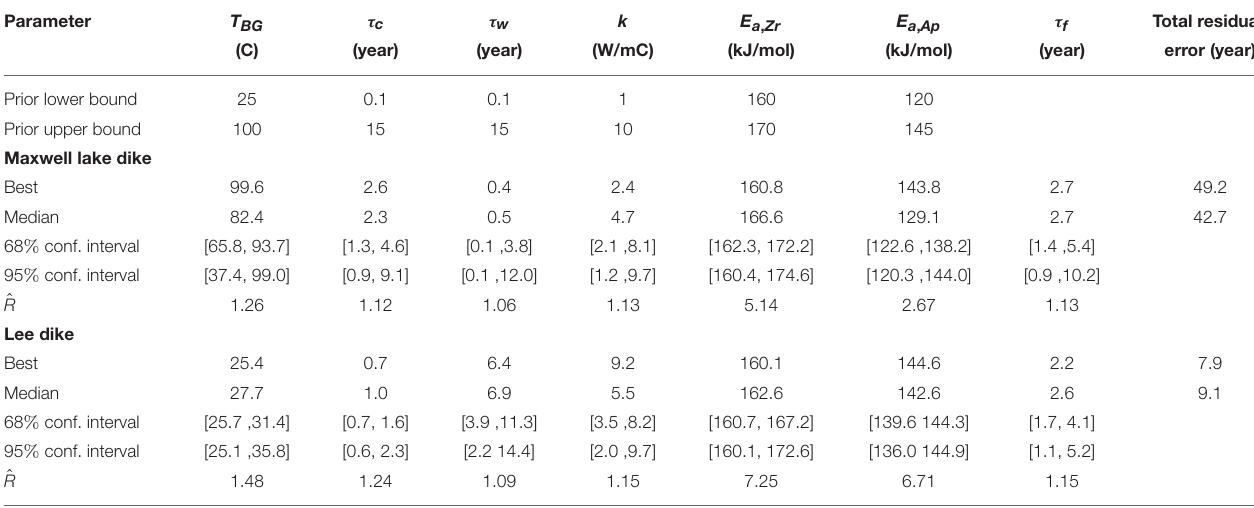
TABLE 1 | Parameters, uniform prior parameter ranges, and MCMC inversion